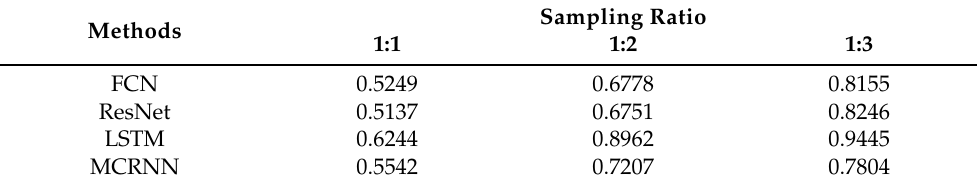
Table 8. F 1 score comparison between the proposed model and the other baseline